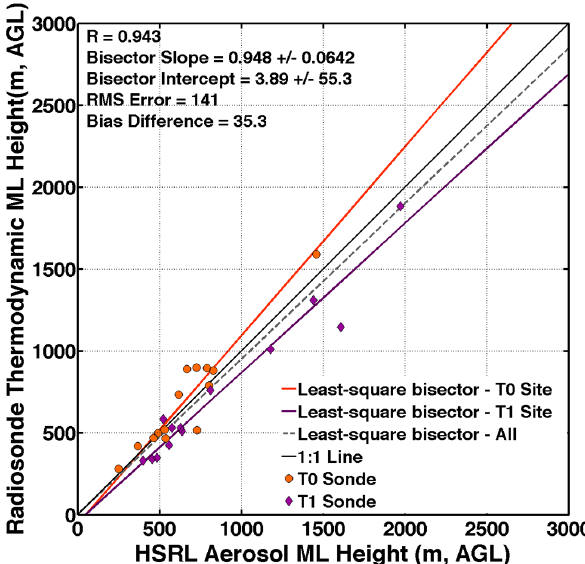
Figure 2. Scatter and bisector regression plot of HSRL aerosol ML heights and radiosonde thermodynamic ML heights within 15km and 30min of the ground sites. The statistics in the upper left cor- ner are for the comparisons when both the T0 and T1 sites are com-